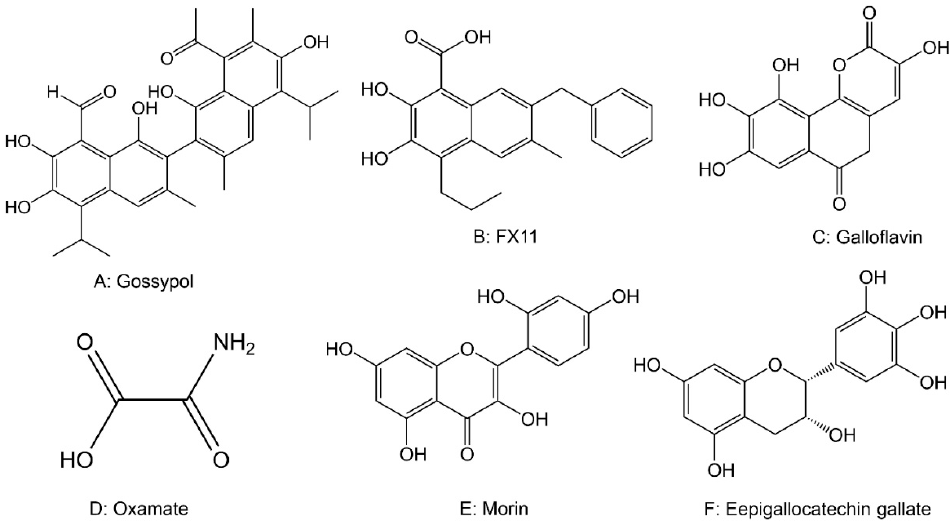
Figure 7. The chemical structures of drugs targeting lactate dehydrogenase.